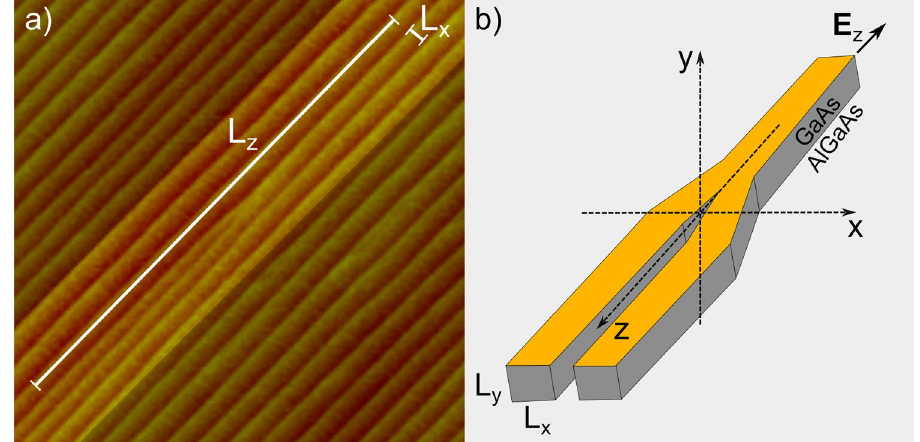
Figure 1. ( a ) Atomic force microscopy image of an GaAs surface of roughy 1.5 × 1.5 µ m 2 , showing the formation of a Y-junction in a NWs network, in the Molecular Bean Epitaxy of GaAs on a (631)-GaAs high- index substrate. ( b ) Schematic illustration of the Y-junction model considered in this